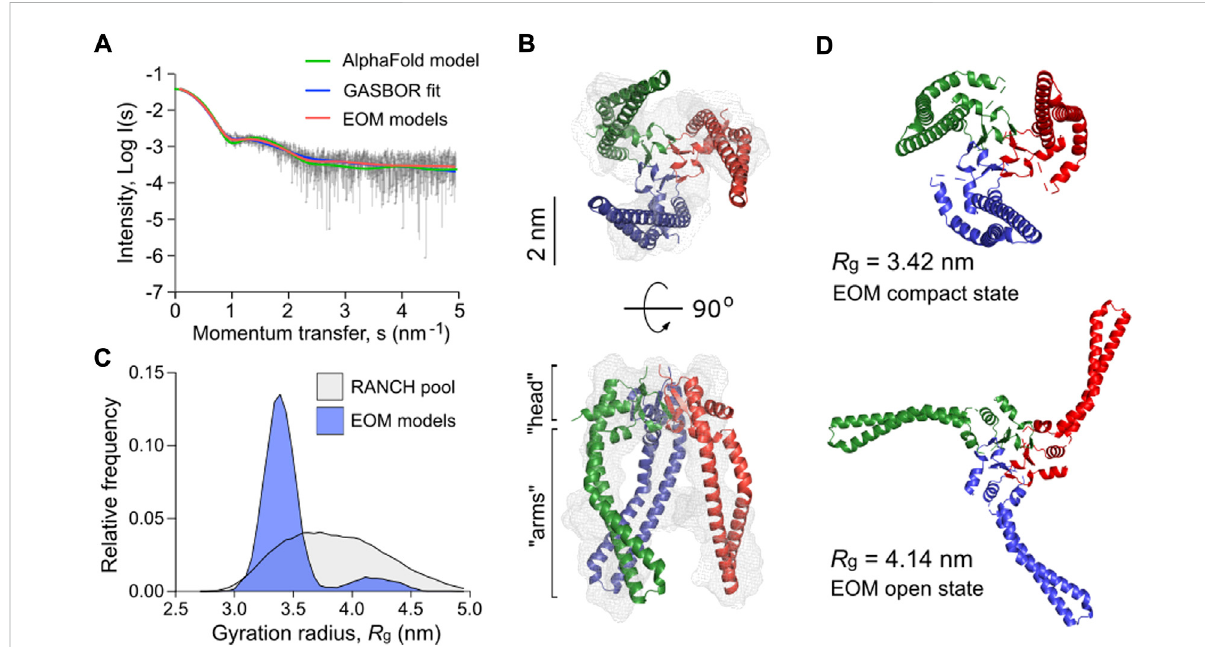
FIGURE 7 P.aeruginosa Skpformsa fl exibletrimerinsolution. (A) ExperimentalSAXSdatacurveisshowningreydotswitherrorbars.Theintensity(log I )is displayedasafunctionofthemomentumtransfer(s).TheintensitypatternsofSkp 3 modelsderivedfromGASBOR(blue),AlphaFold(green),andEOM (red) algorithms are overlaid. (B) The experimental SAXS envelope of P. aeruginosa Skp (grey mesh) calculated using GASBOR algorithm re fl ects the trimeric structure of the chaperone. The structural model of Skp 3 is superimposed with the SAXS envelope, with each protomer coloured individually (red,green,blue).The “ head ” and “ arm ” structuraldomainsofSkpareindicated.Thescale barisshownontheside. (C) Thedistributionof Skp 3 conformationsdifferingbytheirgyrationradii( R g )calculatedbyEOM(blue).TheoriginalRANCHpoolbasedon10000randommodelsisshown in grey. (D) Representative conformations of P. aeruginosa Skp 3 calculated by EOM in the compact ( R g of 3.42 nm, D max of 9.73 nm; fraction ~0.62) and the open ( R g of 4.14 nm, D max of 13.63 nm; fraction ~0.12)